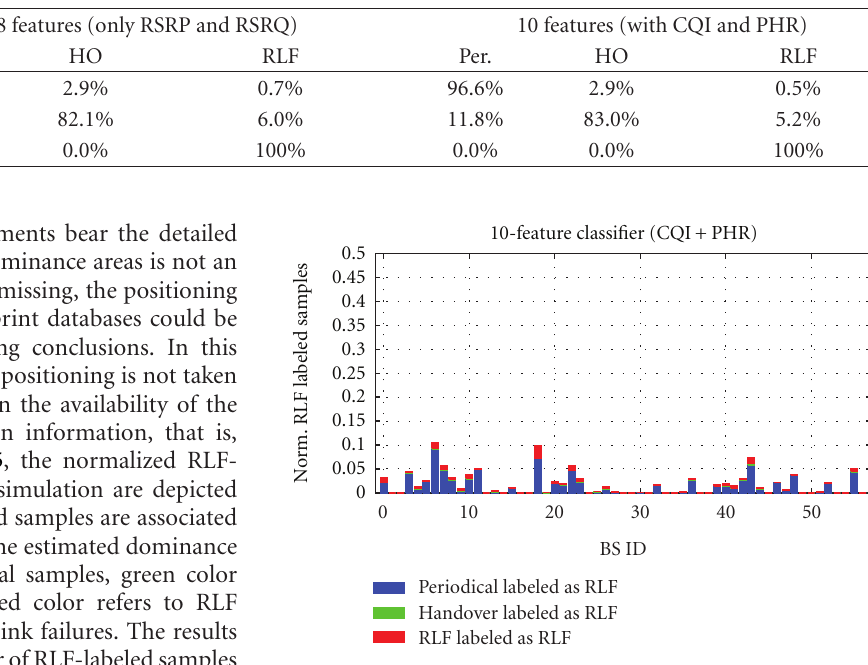
Table 2: Reference simulation confusion matrices.